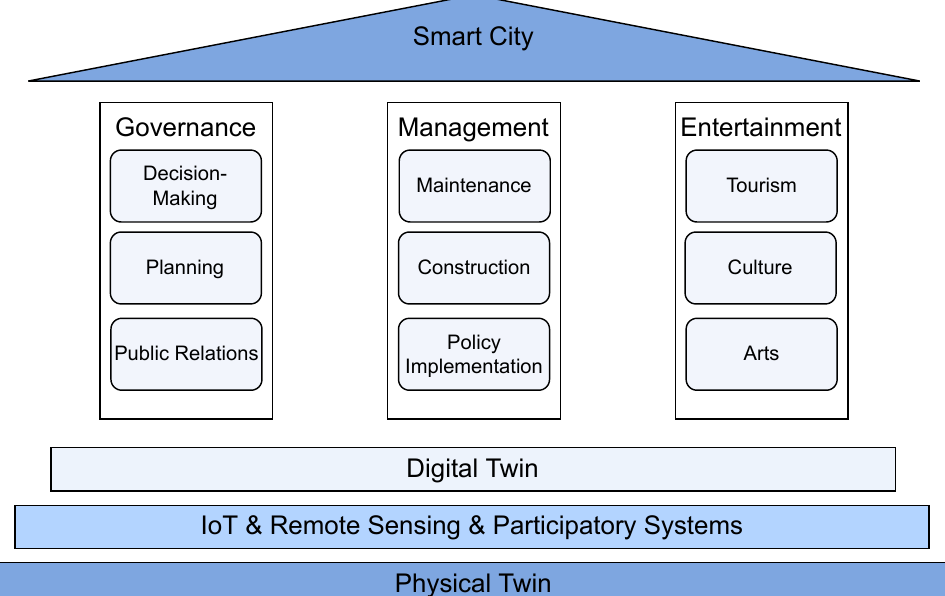
Figure 3. The Smart City with a Digital Twin Foundation . Smart Cities rely on effective data collection, analysis, and communication to work. A DT can provide the required processing of the data collection systems to formalise the PT. In a Smart City, a DT provides analysis for governance, management, and entertainment. While governance refers to directing the city’s future, management refers to the present state of the city, and entertainment refers to the use of the city. Generated with